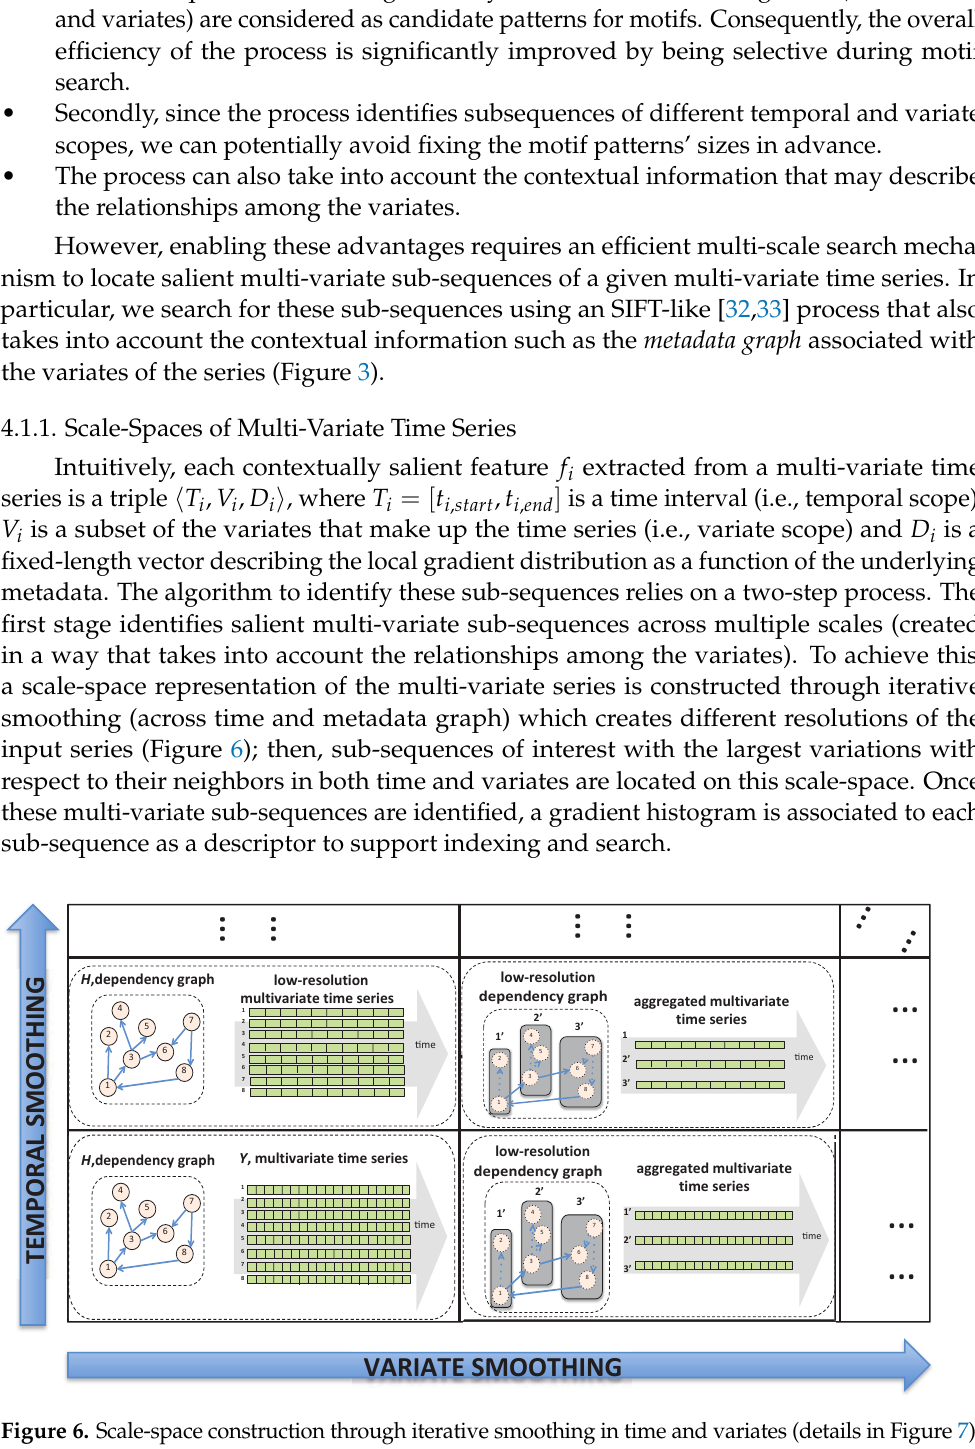
Figure 6. Scale-space construction through iterative smoothing in time and variates (details in Figure 7). Temporal and Variate